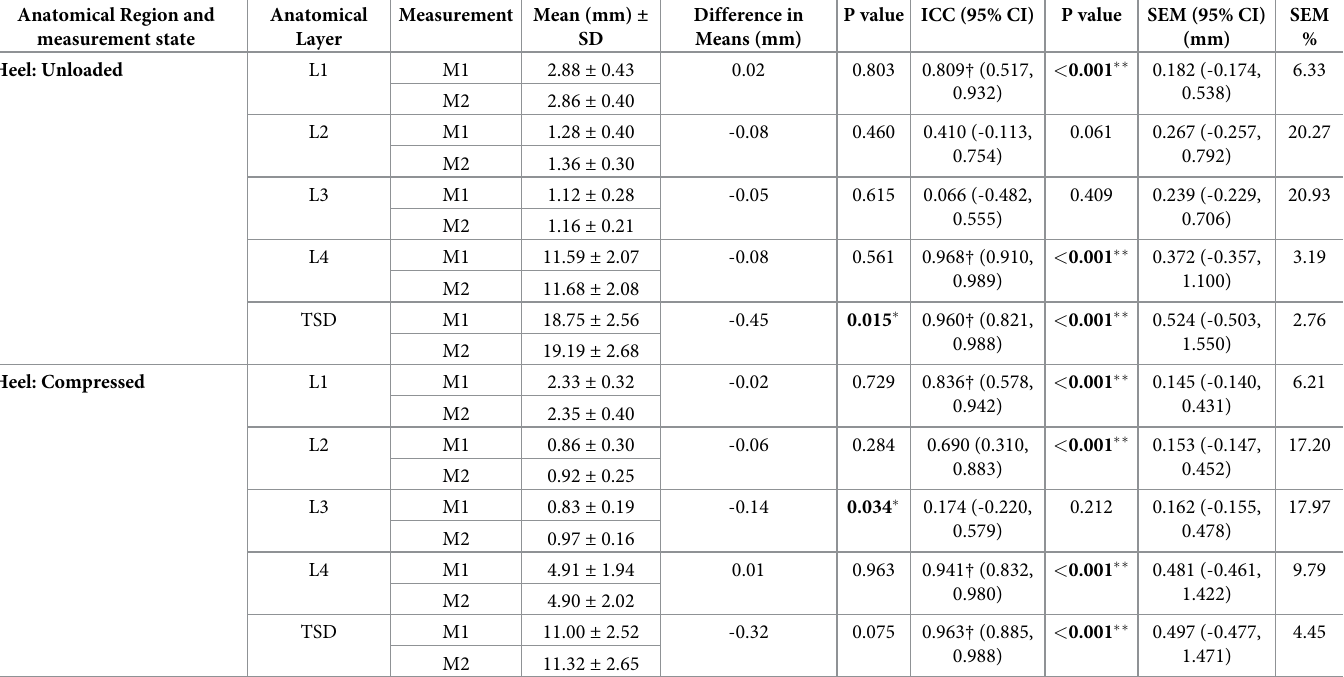
Table 2. Results for intra-observer reliability testing of skin and fat pad thickness at the heel foot region. Anatomical Region and measurement